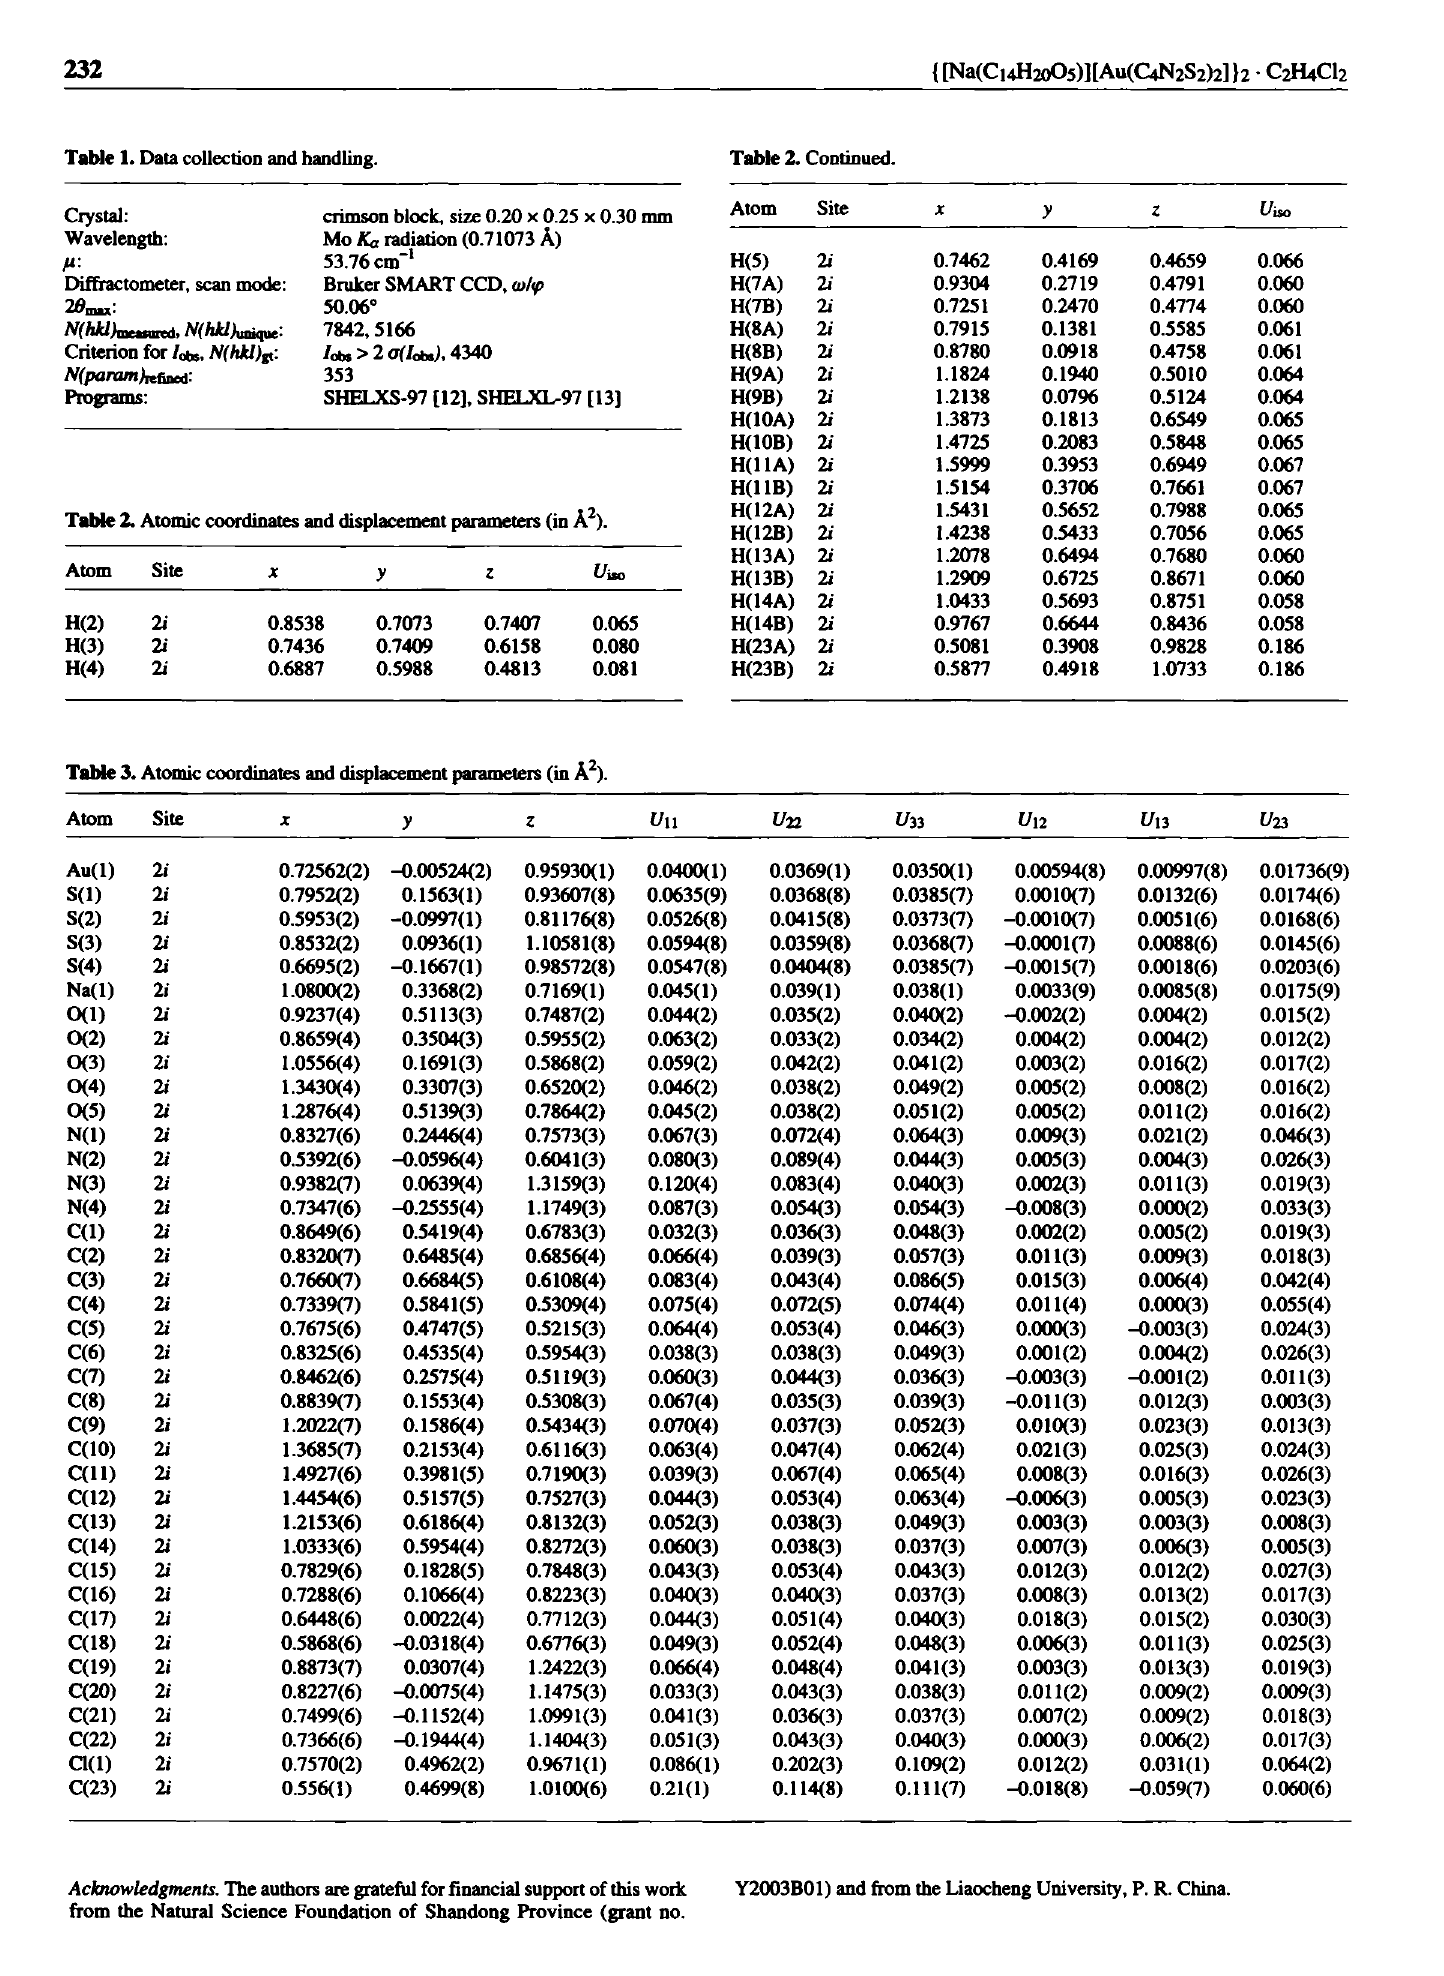
Table 1. Data collection and handling.